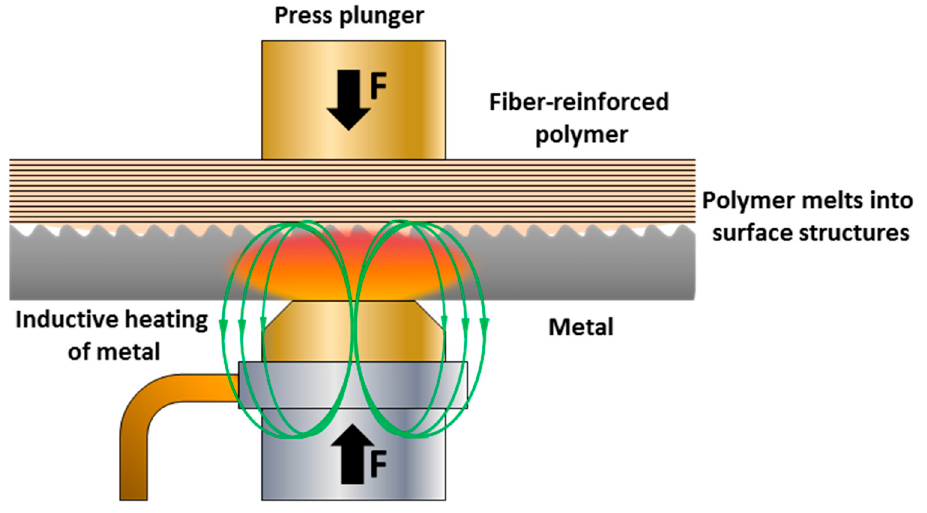
Figure 1. Principle of thermal direct joining .